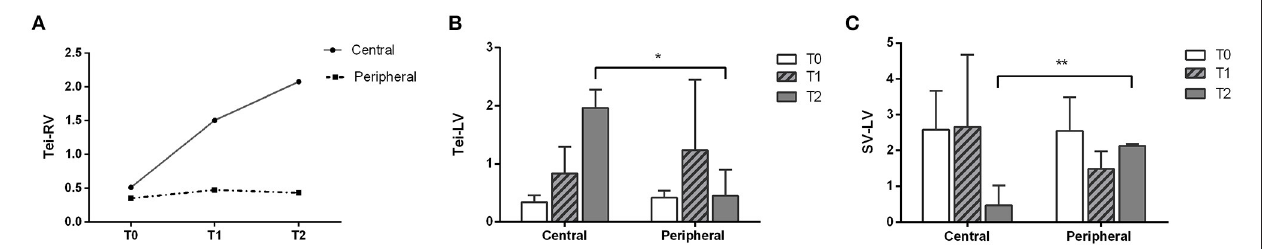
higher than in the peripheral cannulation group at T2 (1.96